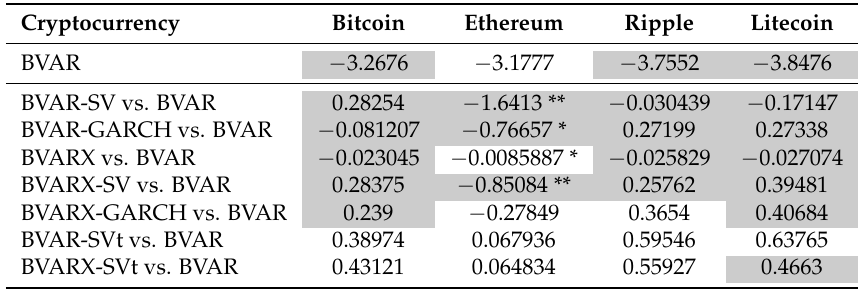
Table 6. Differences of PL against